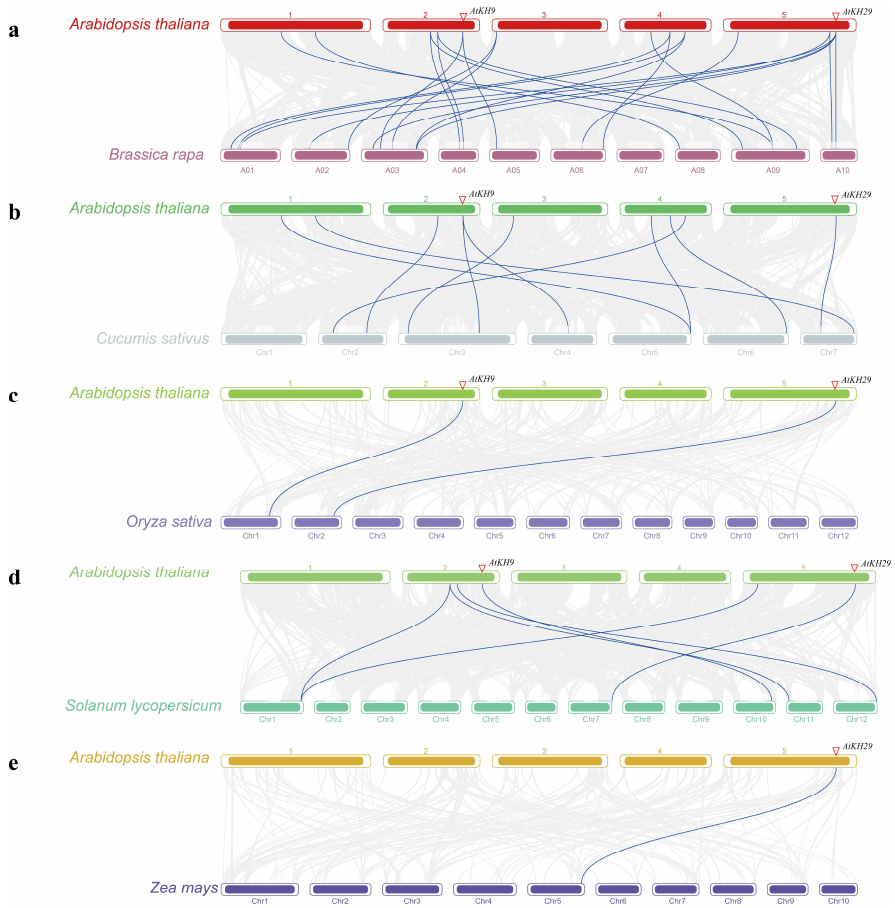
Figure 3. Synteny analysis of KH domain genes in Arabidopsis thaliana and other five species. The gray line represented all genes with synteny between the two species, and the synteny of KH domain genes was represented by the blue line. ( a ) Synteny between A. thaliana and Brassica rapa . ( b ) Synteny between A. thaliana and Cucumis sativus . ( c ) Synteny between A. thaliana and Oryza sativa . ( d ) Synteny between A. thaliana and Solanum lycopersicum . ( e ) Synteny between A. thaliana and Zea mays .